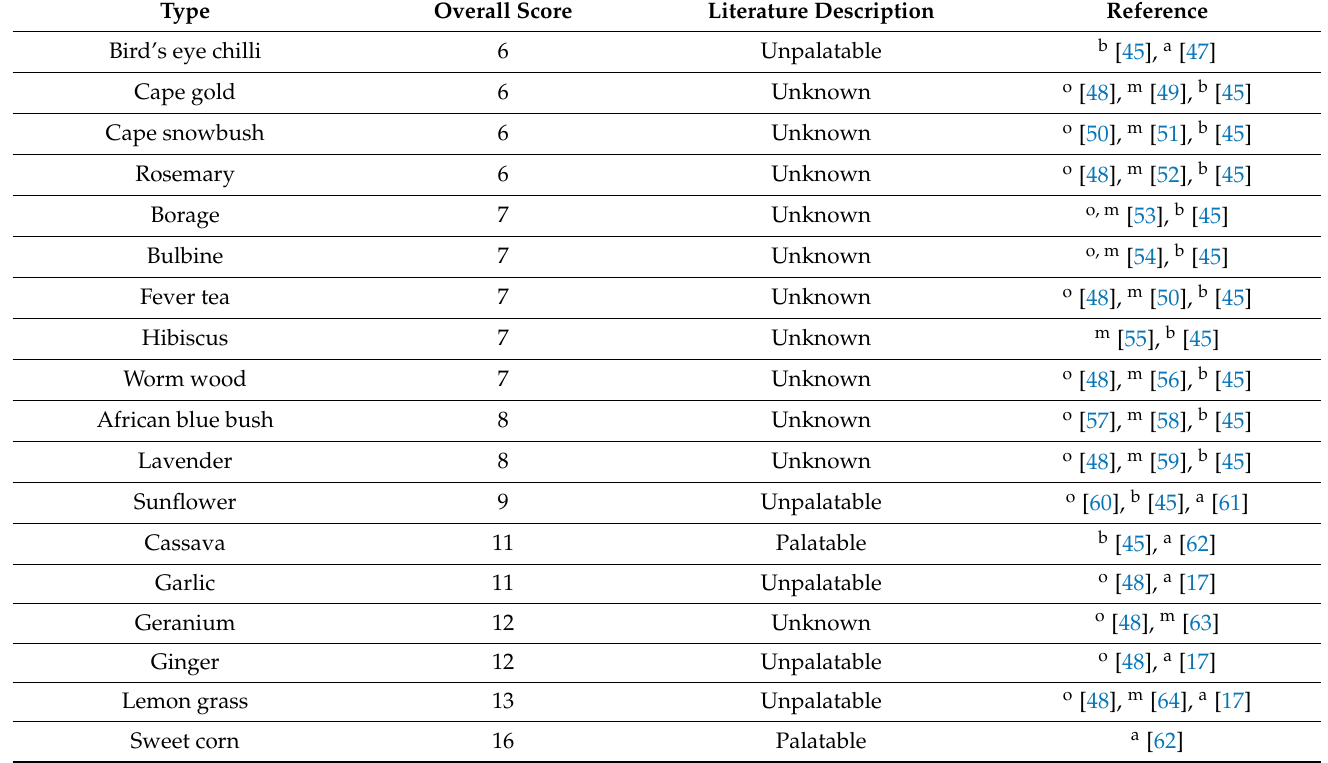
Table 3. The final recommendation for the 18 crops tested in terms of their palatability. The scores were obtained from several factors and not their palatability to elephants alone. Overall scores refer to crops that will be very suitable to test due to their unpalatability to elephants, their growing requirements as well as their versatile economic value (score below 7). Some crops may be unpalatable or edible, but they would be suitable for propagation and have high market values (score 7–10). Others were all edible to the elephants except for ginger so they would be at risk of crop damage (score above